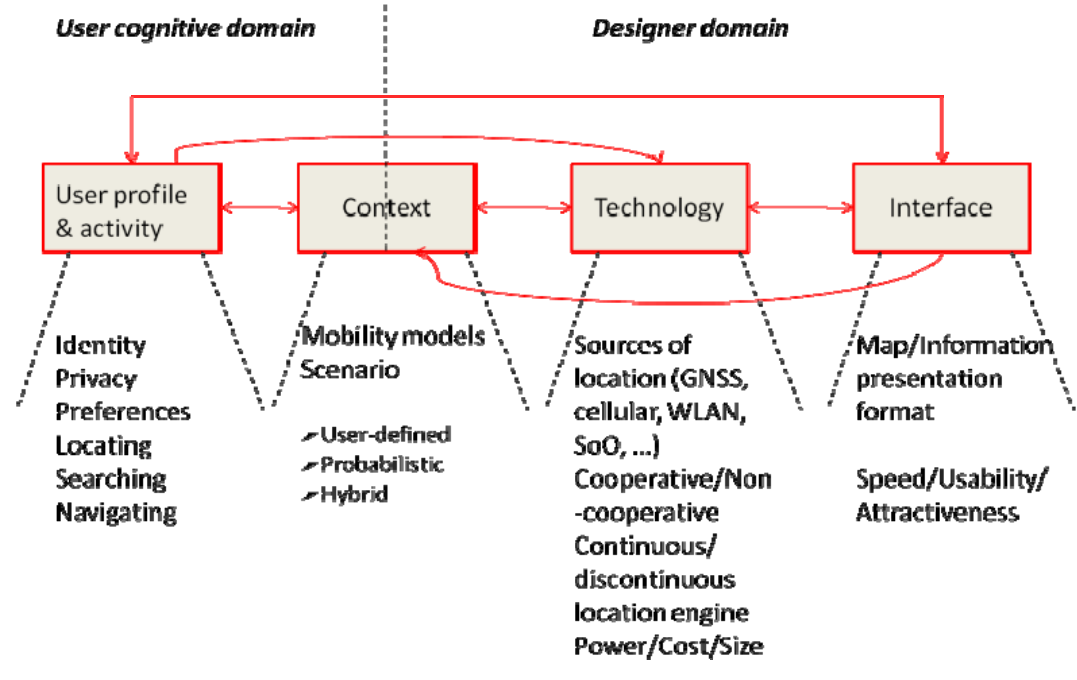
Figure 20. Paradigm of future mobile devices with